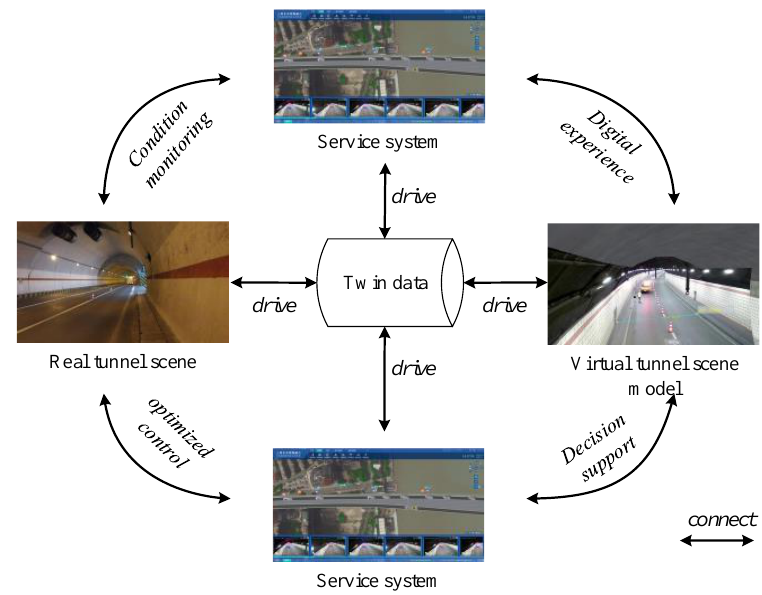
Figure 1. Reference model of the tunnel digital twin structure.